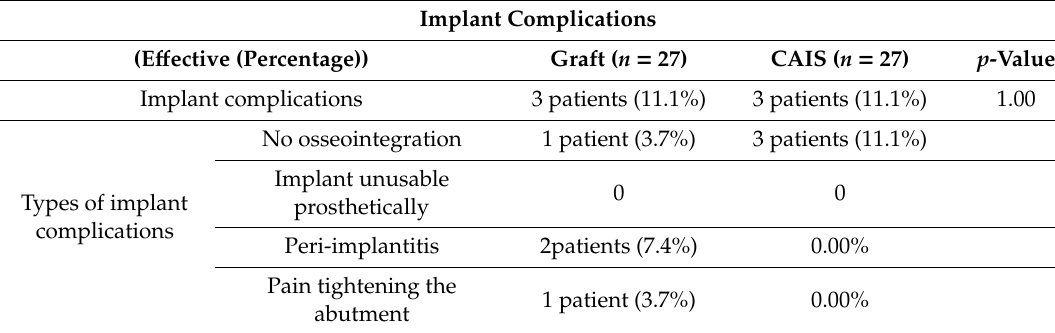
Table 6. Implant complications.